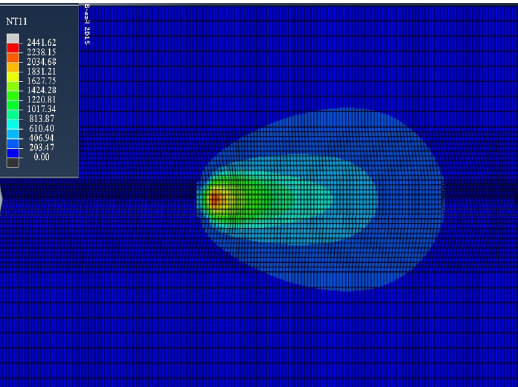
Figure 12. Temperature distribution from the model in the welding